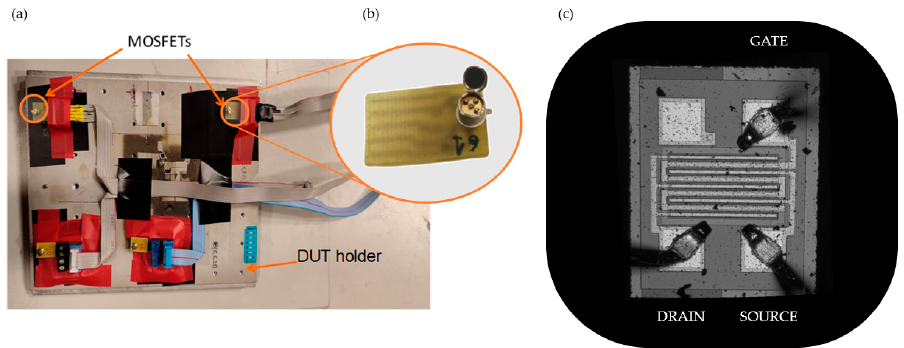
Figure 2. ( a ) Two MOSFET samples placed on the holder. ( b ) Detail of the housing modification showing the silicon die of the MOSFET. ( c ) Silicon die image obtained with the profilometer SNeox.